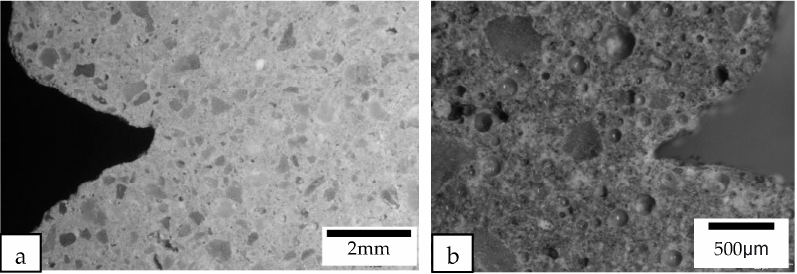
Figure 16. Macrostructure of the cross sections at the interlayer corner of ( a ) the printed control samples and ( b ) the printed samples containing cenosphere aggregate replacement were examined under a microscope.